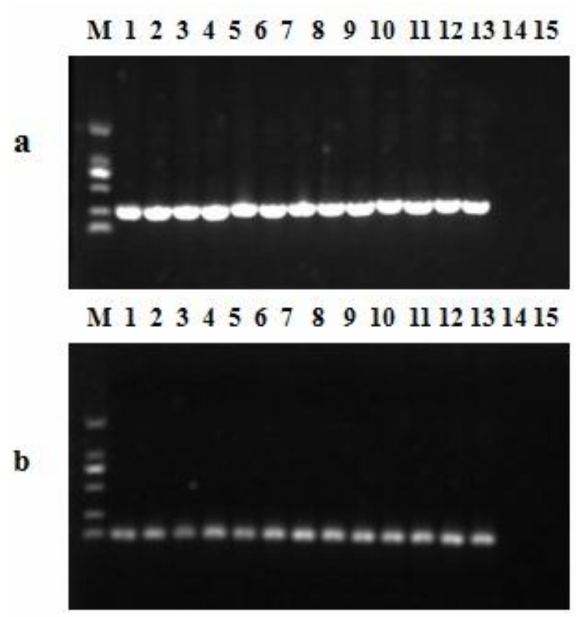
Figure 3. Amplicons of PCR ( a ) and qPCR assay ( b ) from the 51 strains including 13 colistin-resistant isolates carrying the mcr-1 gene, ( a ) primes CLR5-F and CLR5-R (305bp), lane M: DL 2000 Maker, lanes 1–13 the 13 mcr-1 -positive strains, lane 14, the mcr-1 -negative strain, lane 15, no template control; ( b ) qPCR assay (116bp), lane M: DL 2000 Maker, lanes 1–13 the 13 mcr-1 -positive strains, lane 14, the mcr-1 -negative strain, lane 15, no template control.